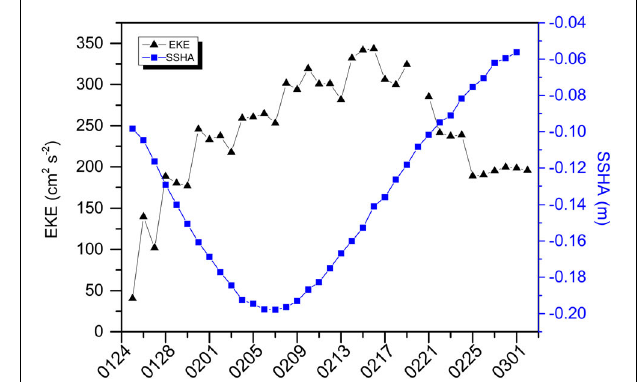
FIGURE 6 | Variations of eddy kinetic energy (EKE) at center of relatively small mesoscale cyclonic eddy (split from the original large one) near station SCS-N, using manual tracking method and daily sea surface height anomaly (SSHA) of 1/4 ◦ × 1/4 ◦ grid area around sampling station from January 25, to March 02,